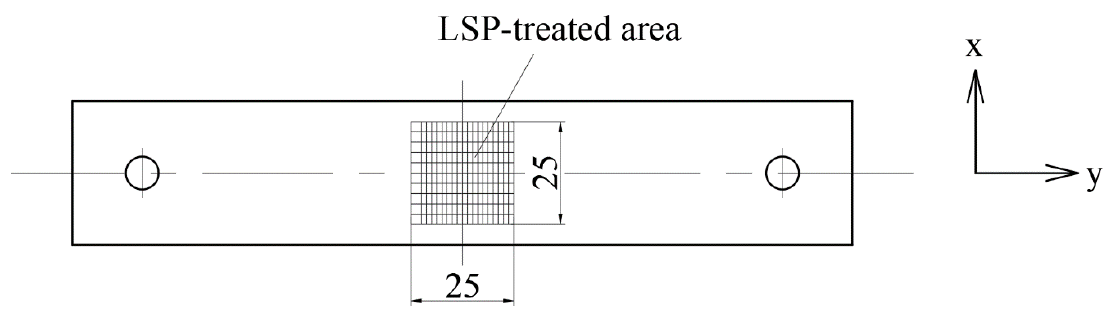
Figure 6. Sketch of the specimen for residual stress analysis. All of the dimensions are in mm.